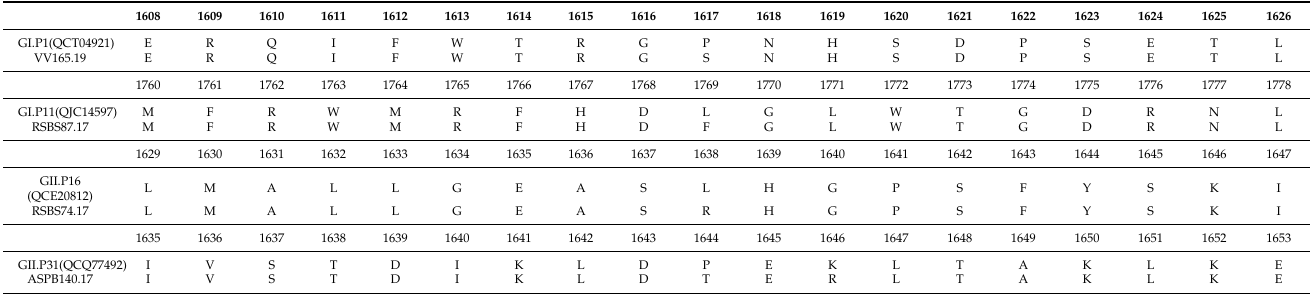
Table 5. Location of amino acid changes in RNA-dependent RNA polymerase (RdRp) sequences. Aminoacid positions refer to the corresponding reference strain in each